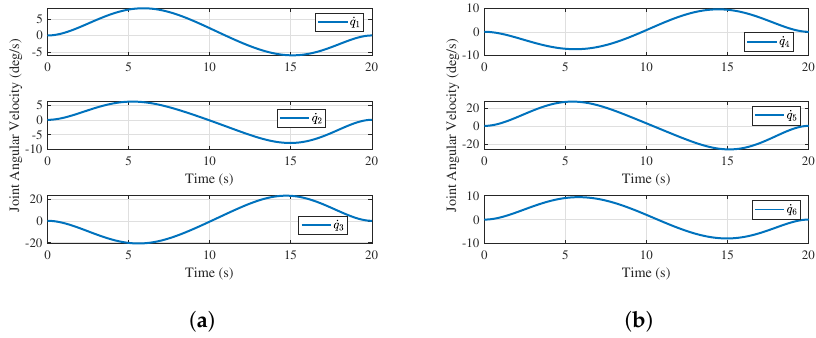
Figure 15. Velocity variation curves of i th joint, where ( a ) i = 1, 2, 3, and ( b ) i = 4, 5, 6.